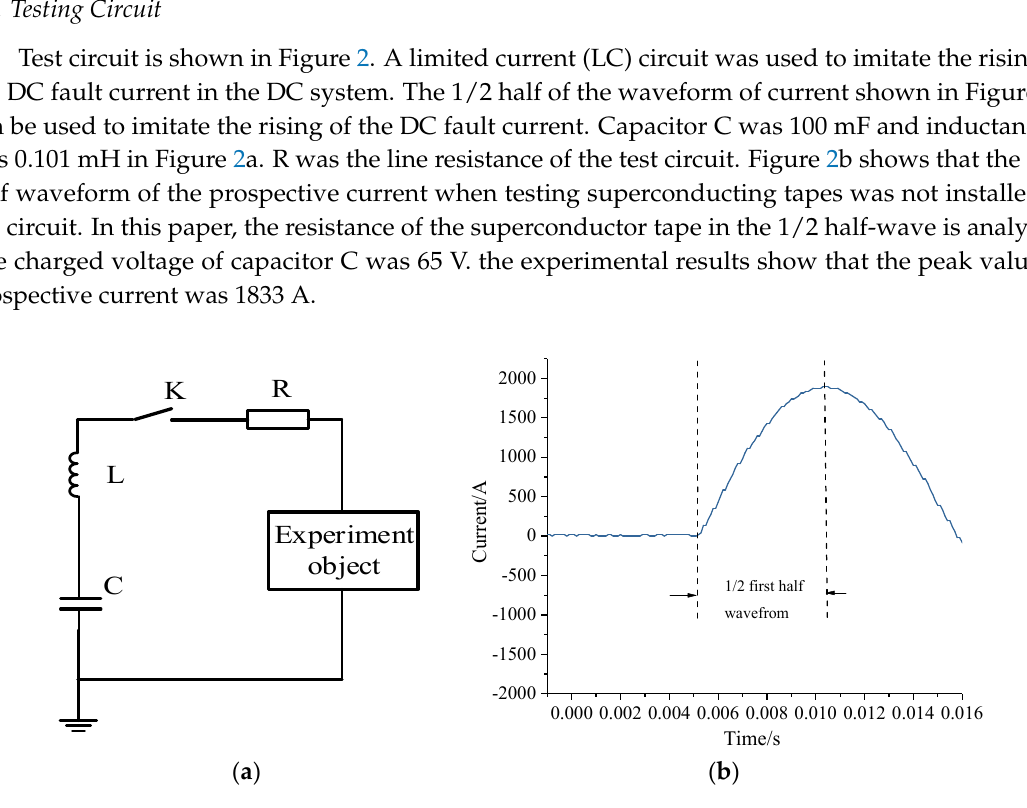
Figure 2. Test circuit and first half waveform of prospective current .